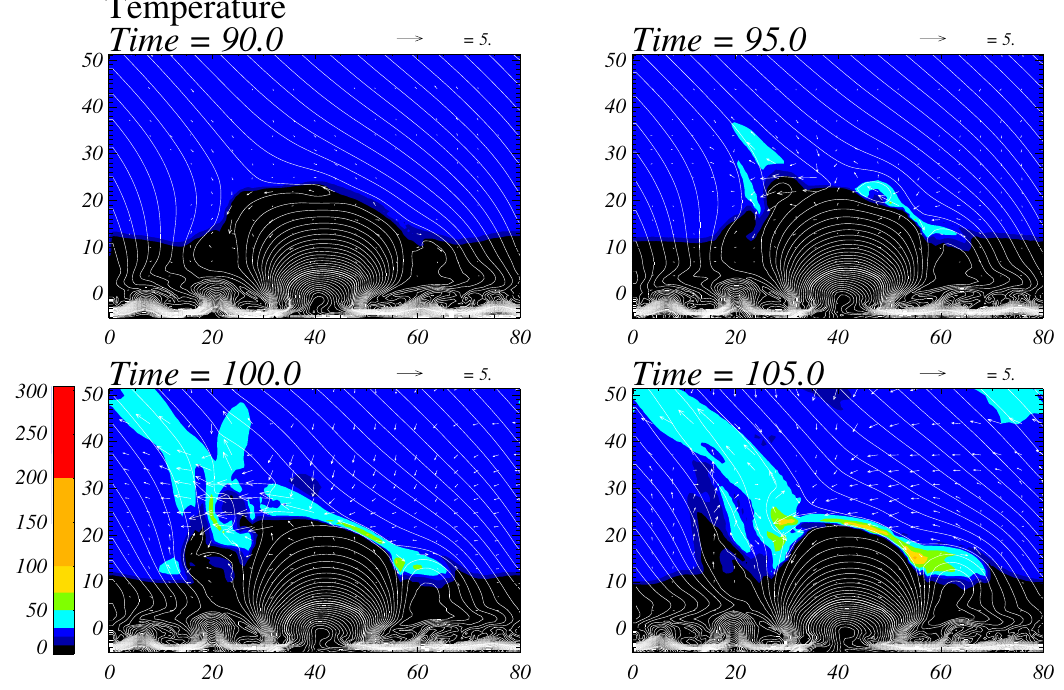
Figure 49: Temporal evolution of temperature (color), velocity (arrows), and magnetic field lines of 2D simulation of emerging flux with pre-existing oblique fields. Image adapted from Yokoyama and Shibata (1996), courtesy of T.